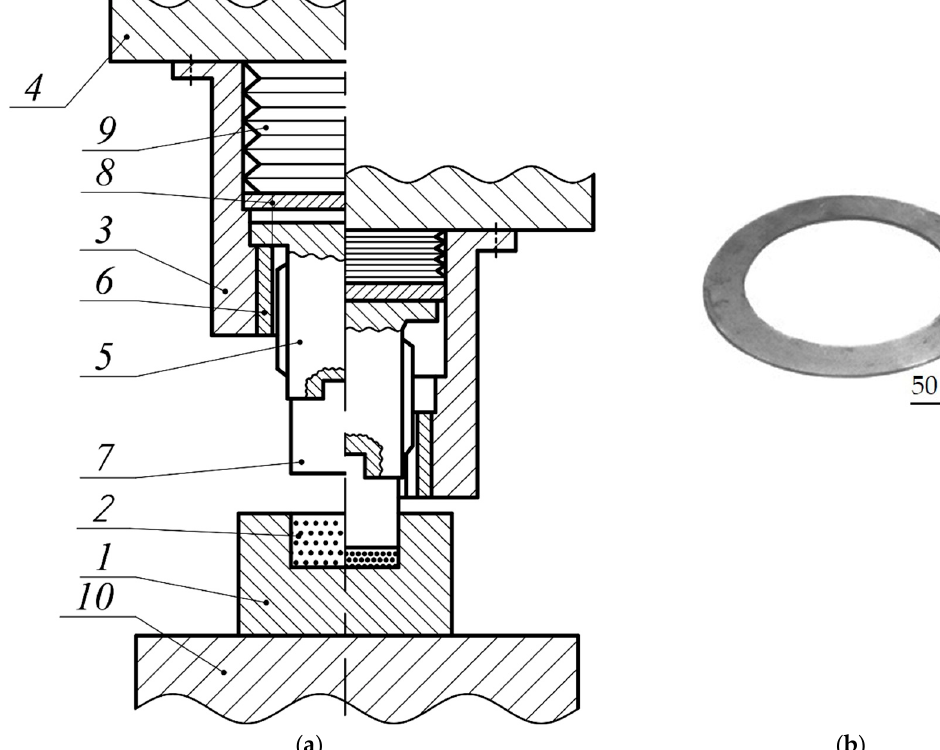
Figure 5. Design of the stamp for preforming of the powder: ( a ) a general scheme, where 1—block; 2—cavity for powder; 3—frame; 4—plate; 5—screw; 6—nut; 7—punch; 8— 2—cavity for powder; 3—frame; 4—plate; 5—screw; 6—nut; 7—punch; 8—restrictive plate; 9—spring restrictive plate; 9—spring element; 10—press table; ( b ) a preform produced with an element; 10—press table; ( b ) a preform produced with an external diameter of 130 mm, internal diameter of 95 mm, and thickness of 0.3 external diameter of 130 mm, internal diameter of 95 mm, and thickness of 0.3 mm.